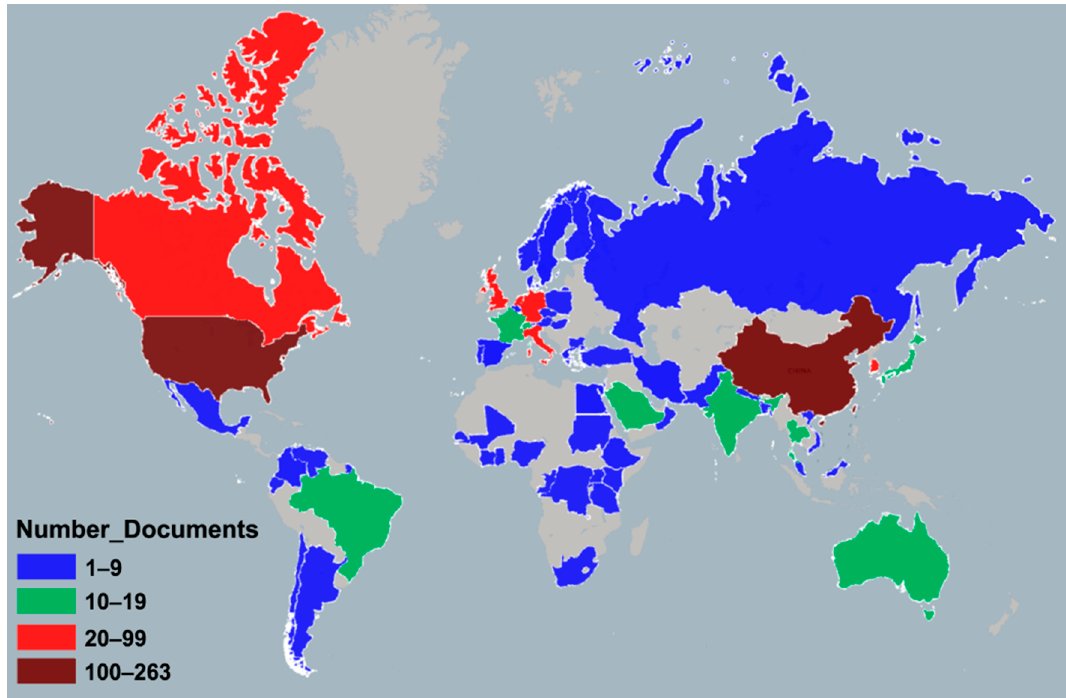
Figure 9. Geographical distribution of SARS-CoV-2 publications. (Note: regions with no colors in the map have no available data).